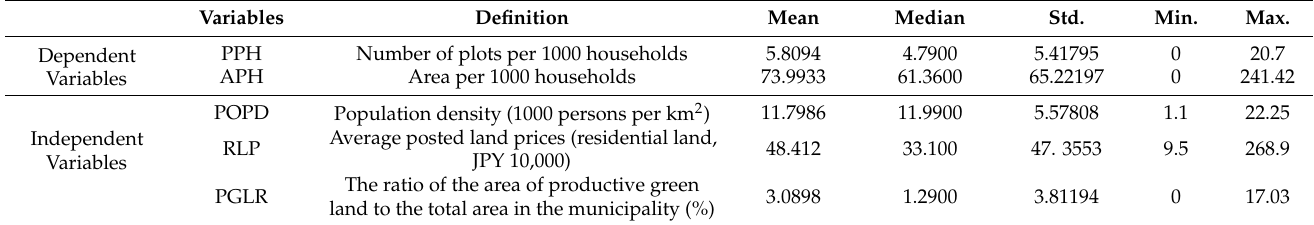
Table 4. Variables and statistical description.